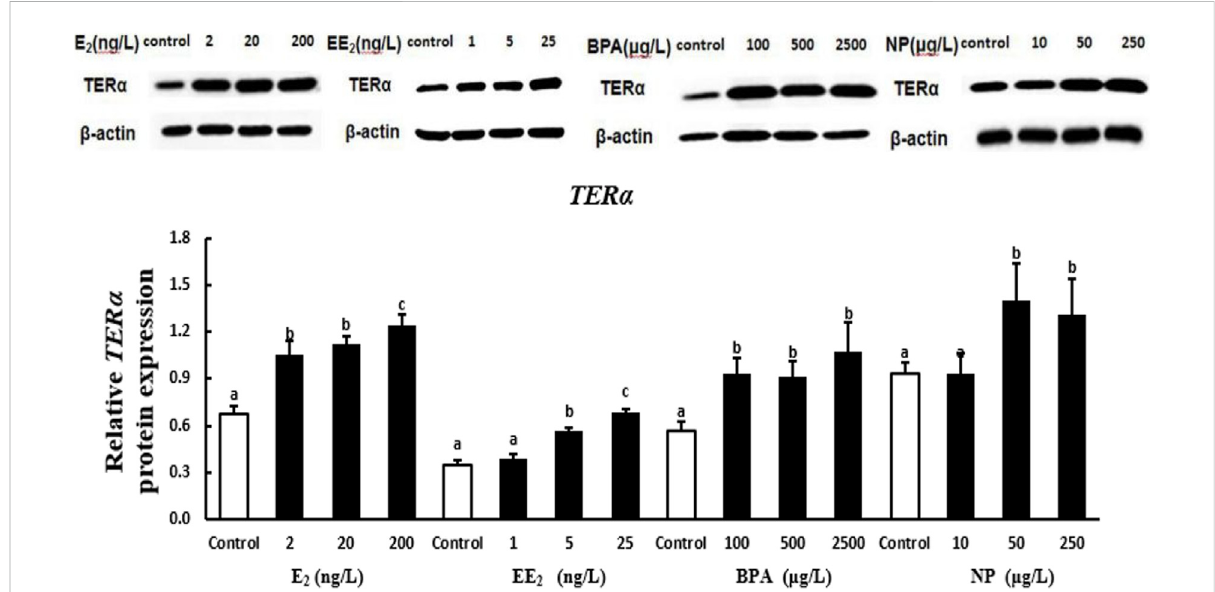
FIGURE 5 Effects ofEDCs on the level of the protein encoded by ter α inthe testis of T.albonu bes. Columns with different letters are signi fi cantly different at p < 0.05 according to one-way ANOVA followed by Dunnett ’ s